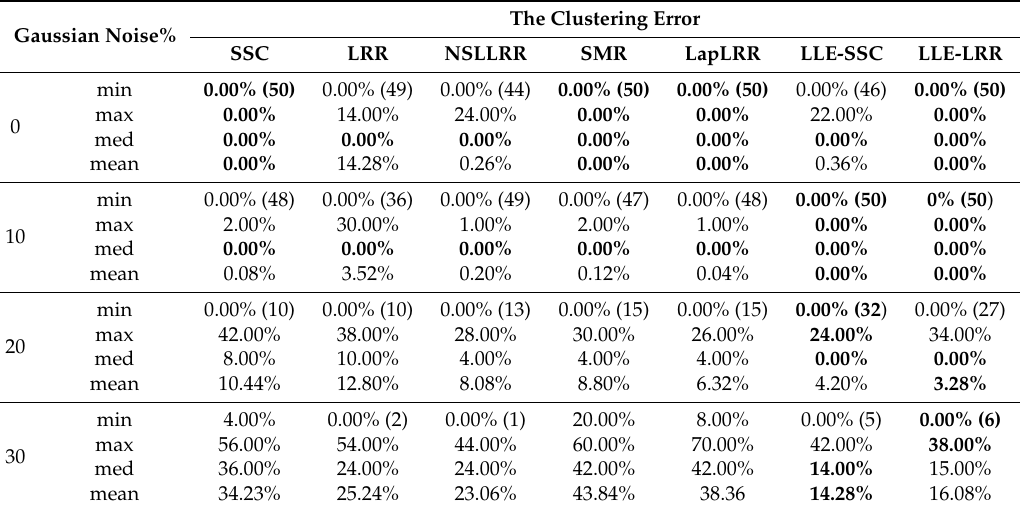
Table 2. Clustering results on the synthetic hyper spectral mineral dataset with various magnitudes of Gaussian noise, lower is better. Numbers in brackets indicate how many times clustering was perfect, i.e., zero error. The best results are in bold